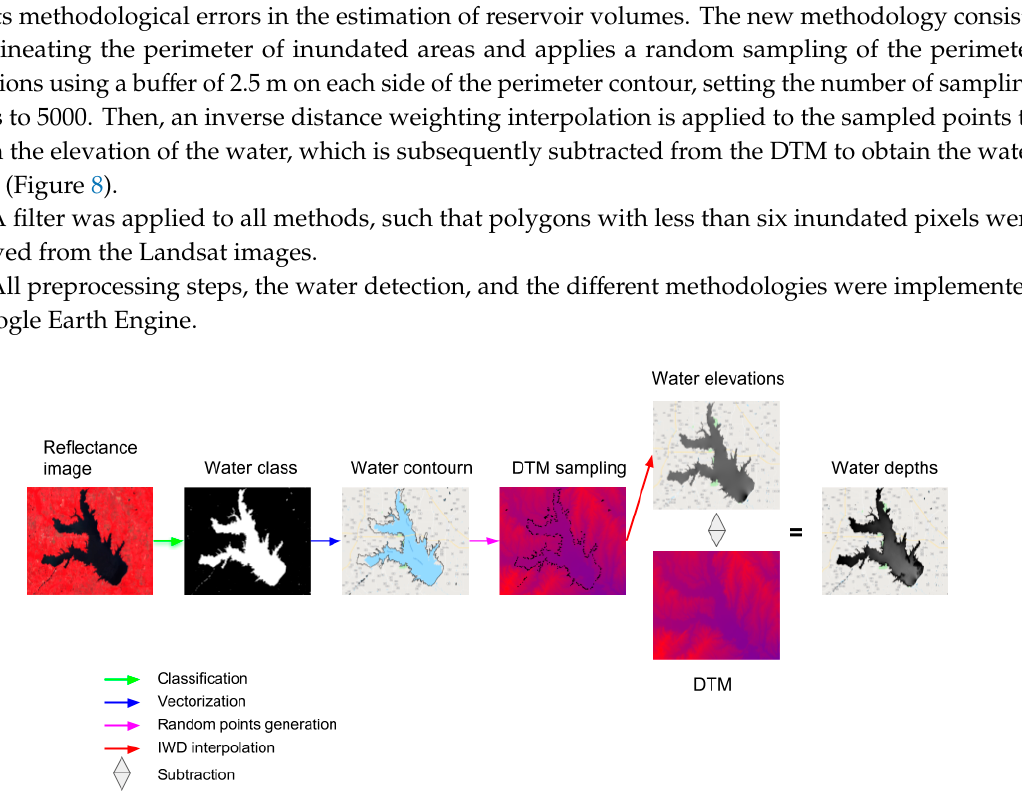
Figure8. Figure 8. Schema of inverse distance weighting interpolation (IDW) methodology for water volume estimation.